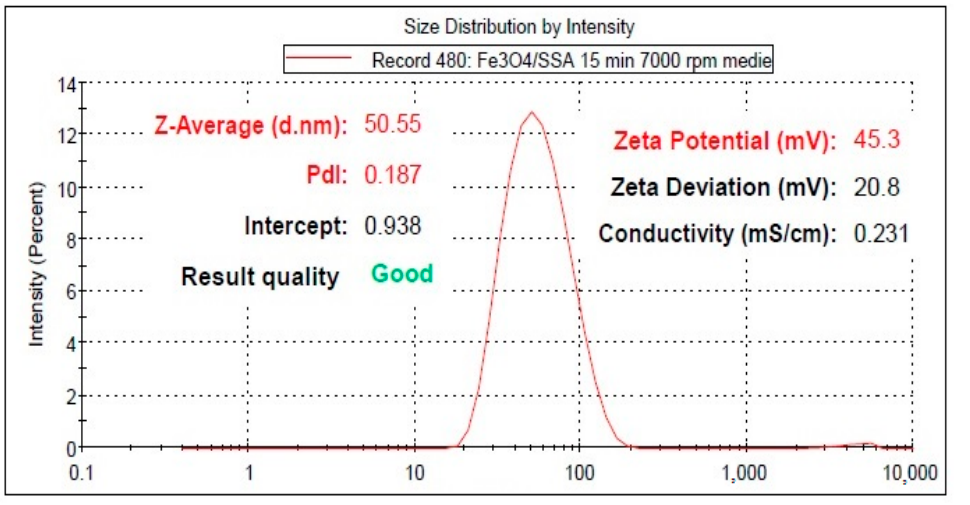
Figure 3. The results of the dynamic light scattering (DLS) analysis for the Fe 3 O 4 –SSA synthesized nanoparticles indicate good dispersion stability.